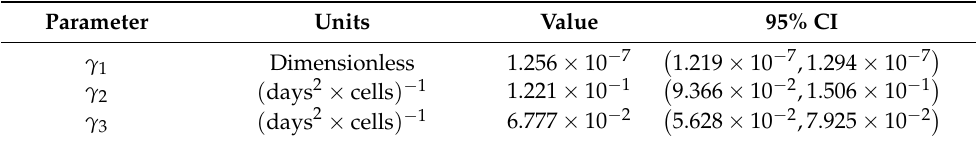
Table 5. Parameters and 95% CI for the CAR-T cytotoxicity rate Equation (12). Parameter Units Value γ